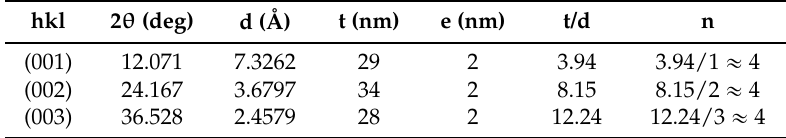
Table 3. Estimated crystallite size and related parameters for bismoclite from San Francisco de los Andes.